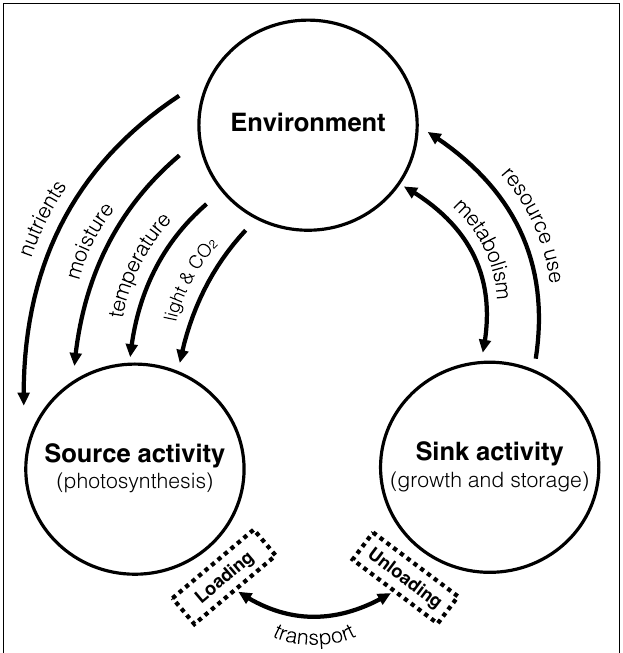
FIGURE 1 | Major influences of changing environmental conditions on the relationship between source-sink dynamics. Adapted from (Korner, 2015).